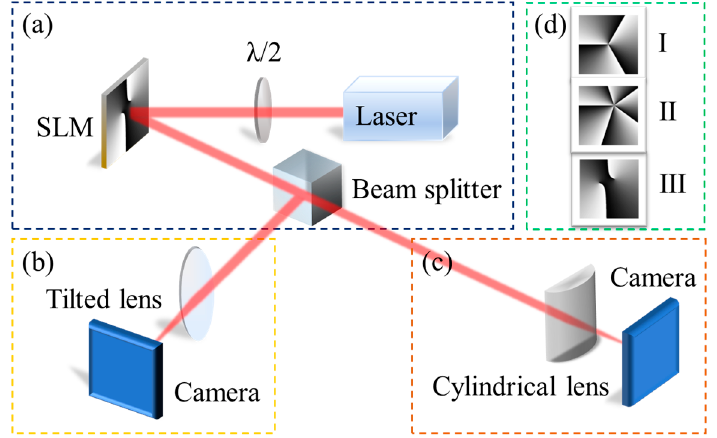
Figure 2. Schematic experimental setup. The setup consists of three parts: ( a ) the generation of the vortex beams, ( b ) TC detection, and ( c ) OAM measurement. ( d ) Exemplary phase masks projected on the SLM for generating (I) on-axis vortex, (II) off-axis single vortex, and (III) off-axis double vortex beams.